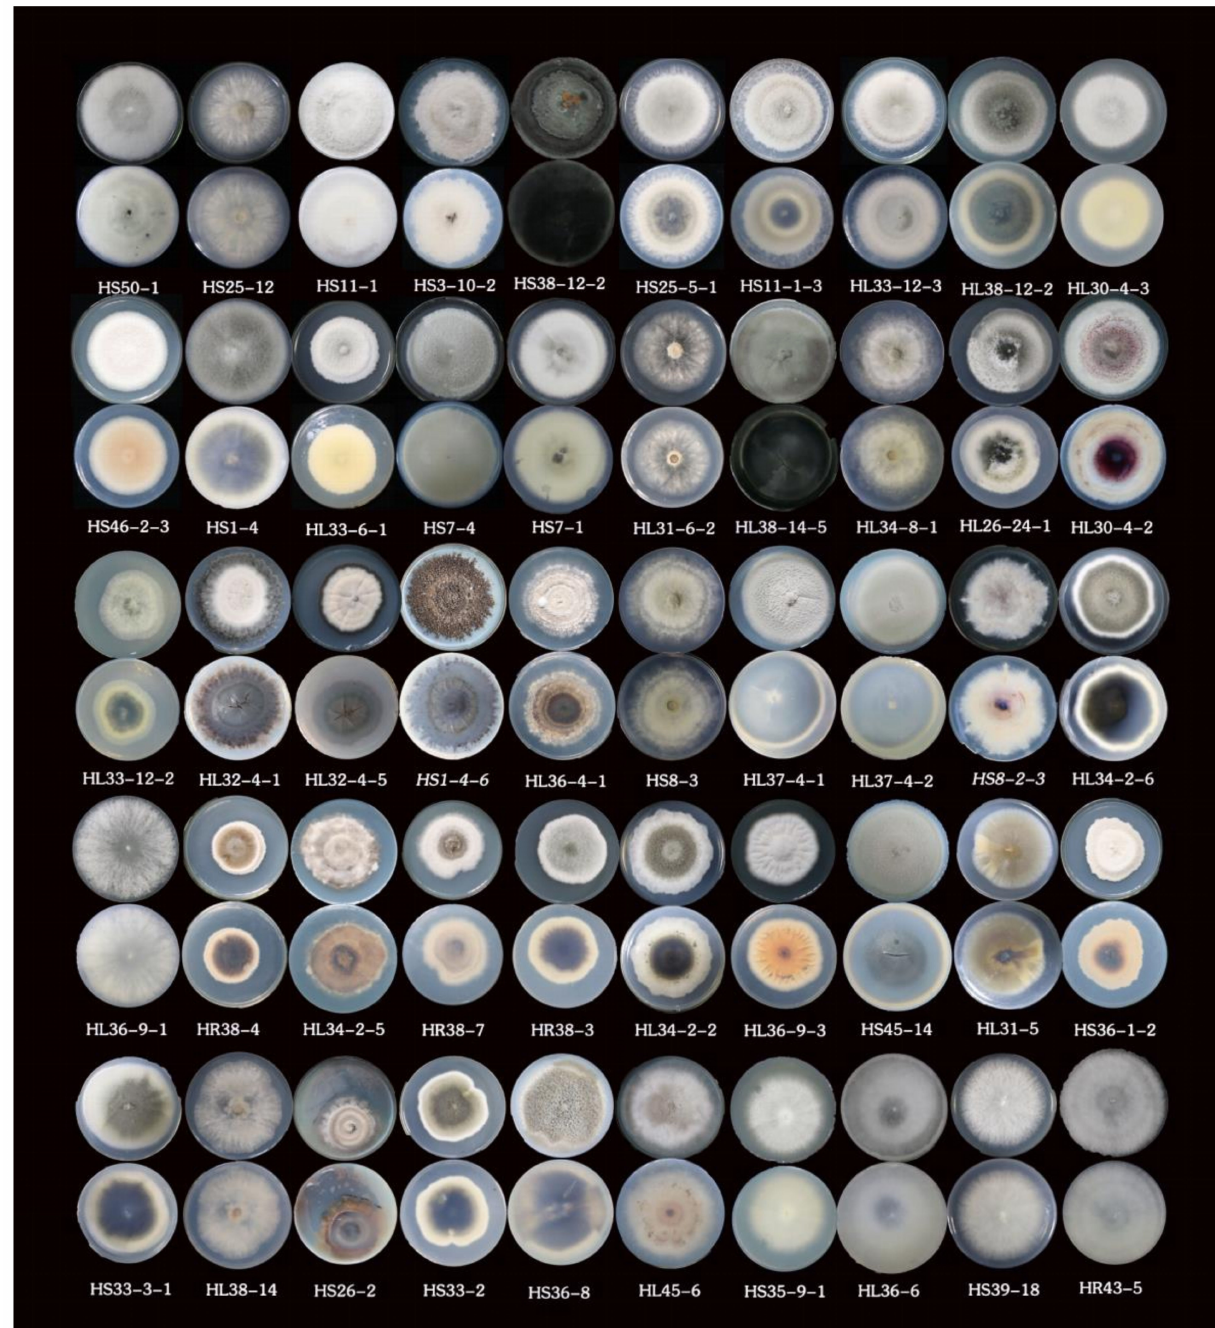
Figure 7. Colonies of the endophytic fungi from H. serrate. HS50-1, HS25-12, HS11-1, HL38-12-2, HS3-10-2, HS38-12-2, HS25- 5-1, HS11-1-3, and HL33-12-3 represent Colletotrichum gloeosporioides . HL30-4-3, HS46-2-3, HS1-4, HL33-6-1, HS7-4, HS7-1, HL31-6-2, and HL34-8-1 represent Colletotrichum boninense . HL26-24-1 represents Colletotrichum tabaci , HL30-4-2 shows Colletotrichum acutata , HL33-12-2 shows Fusarium lateritium , HL32-4-1 and HL32-4-5 represent Pseudocercospora rubi , HS1-4-6 shows Guignardia mangiferae , HL36-4-1 and HS8-3 show Leptostroma sp. , HL37-4-2 and HL37-4-1 show Arthopyreniaceae sp. , HS8-2-3 shows Microsphaeropsis arundinis , HL34-2-6 and HL36-9-1, HR38-4, HL34-2-5, HR38-7, HR38-3 and HL34-2-2 to Alternaria alternate , HL36-9-3 to Epicoccum nigrum , HS45-14, HL31-5, HS36-1-2, HS33-3-1, HL38-14, HS26-2, HS33-2, HL45-6 and HS36-8 to Phoma herbarum , HL36-6 and HS35-9-1 to Bjerkandera adustus , and HS39-18 and HR43-5 to Trametes